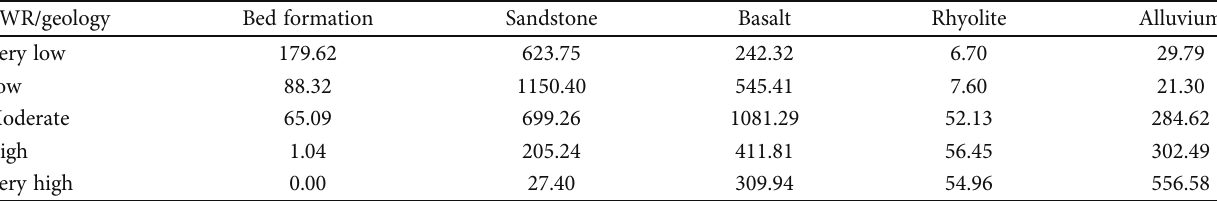
Table 13: Cross-tabulation between GWR and geology.